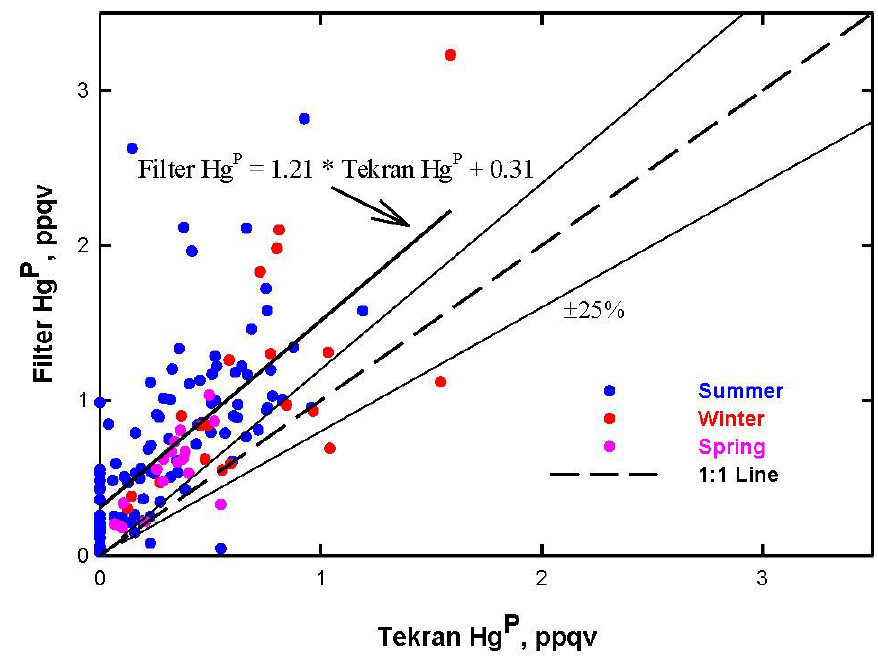
Figure 4. The relationship between filter Hg P and the integrated Tekran Hg P during the summer, winter, and spring seasons. The dashed line represents the 1:1 relationship and the two solid lines surrounding it mark the ±25% boundaries. The other solid line represents a linear fit of between the filter Hg P and the integrated Tekran Hg P